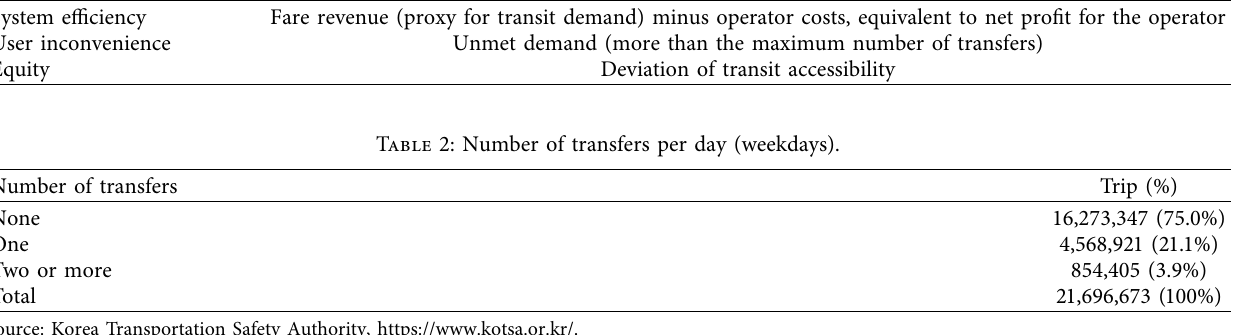
Table 3: Probelm notation.